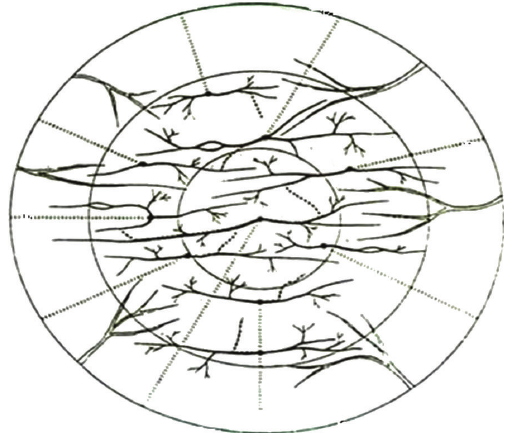
Figure 1: Sensory nerve fibers in the human cornea. The stromal nervesaremoreevidentalongthehorizontalmeridianofthecornea, less along the vertical